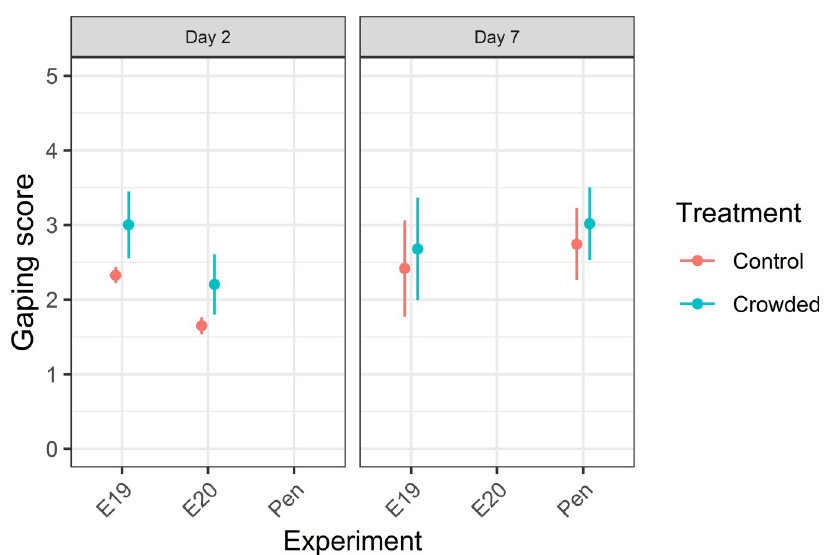
Fig 3. Post-mortem gaping response to crowding in Atlantic mackerel fillets. Gaping scores were obtained either two (“Day 2”) or seven (“Day 7”) days after death. Model predicted mean values are shown as filled circles for the different experiments, with associated 95% confidence intervals as whiskers. Data points are coloured according to treatment.